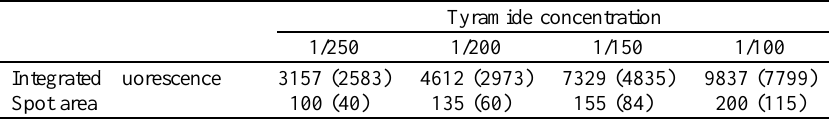
Table 3 Effect of the tyramide concentration on signal characteristics